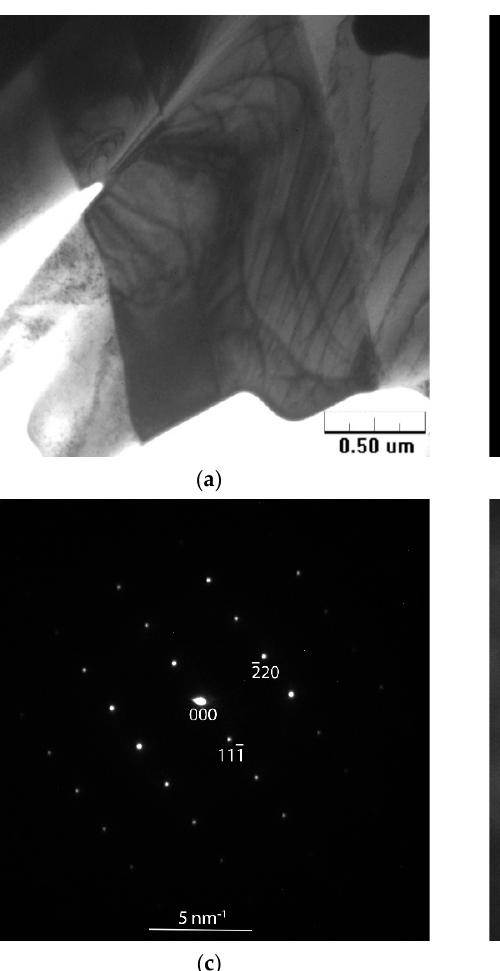
Figure 7. ( a ) TEM image of a thin area of Re 0.3 NbTiZr foil containing a second phase particle. ( b ) Combined selected area diffraction pattern (SADP) from the particle ([110] FCC zone axis) and the matrix ([113] BCC zone axis, indexed reflections are underlined). ( c ) Selected area diffraction of [112] FCC from the particle. ( d ) A convergent-beam [111] FCC zone axis pattern from the second-phase particle indicating 3m symmetry in the transmitted disc.